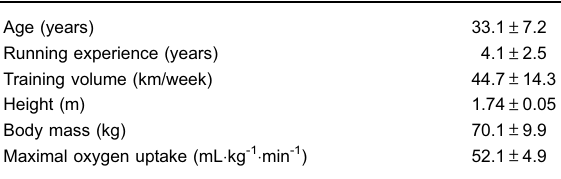
Table 1. Characteristics of the runners that participated in the